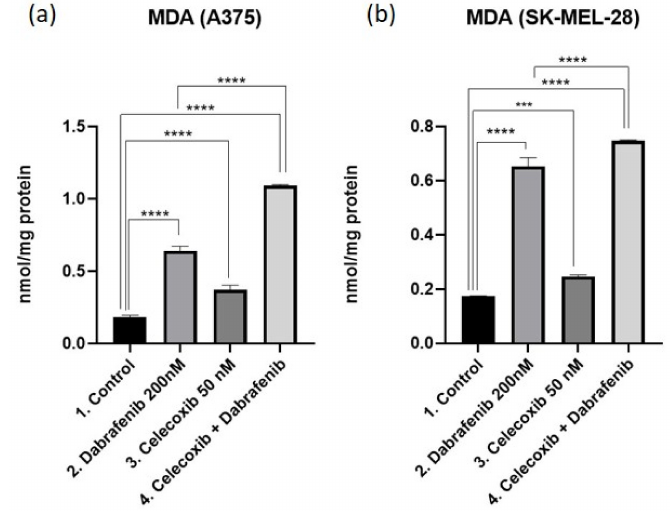
Figure 4. MDA as a marker for oxidative stress. MDA measurements in A375 ( a ) and SK-MEL-28 ( b ) were done by spectrophotometry. Results were statistically analyzed using GraphPad Software, Ordinary One-way ANOVA test, Multiple comparisons. Each bar represents mean ± standard deviation, n = 3. *** = p < 0.001, **** = p < 0.0001.